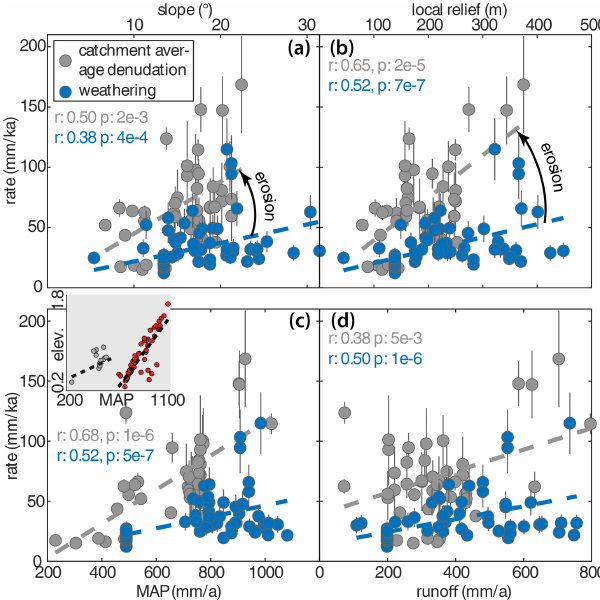
Figure 4. Correlations between catchment average 36 Cl denudation rates, carbonate weathering rates, and topographic and climatic met- rics based on linear regression. Values of correlation coefficient and p value displayed for catchment-averaged denudation and weath- ering rates. Inset (c) : Correlation between mean annual precipita- tion (MAP) and elevation illustrating orographic precipitation in the analysed areas (Israel, grey; France and Crete,